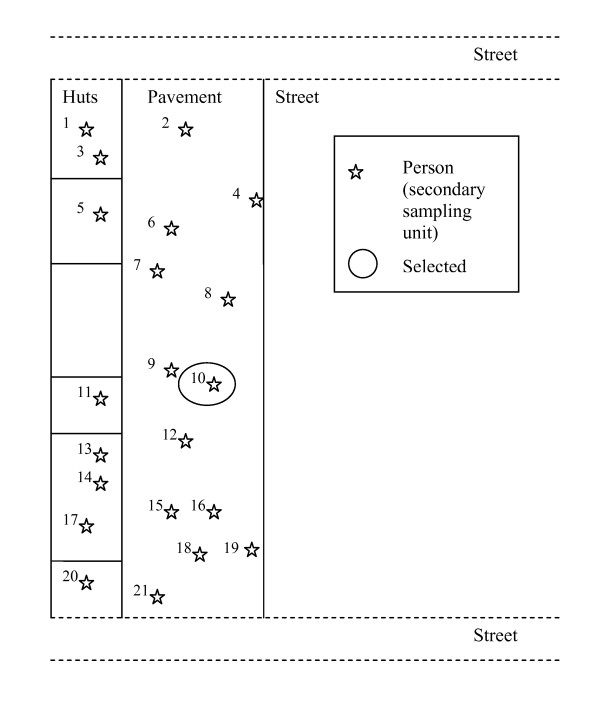
Primary sampling unit (illustrative).